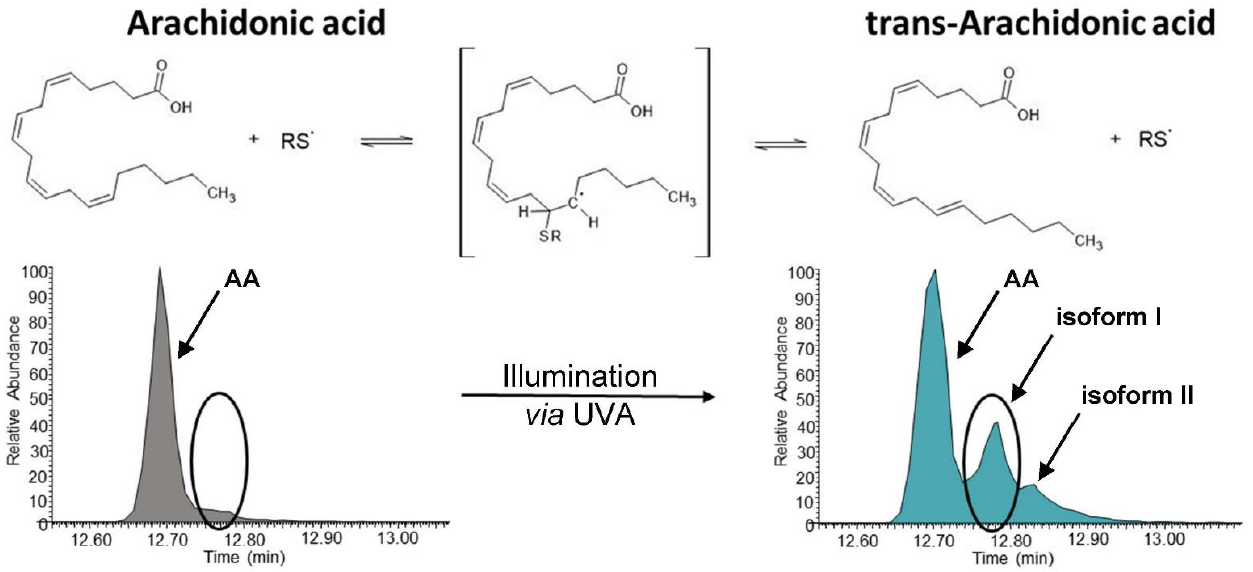
Biomolecules 2022 , 12 , x Figure 3. Formation of trans-arachidonic acid isoforms I and II obtained by UVA illumination of Figure 3. Formation of trans -arachidonic acid isoforms I and II obtained by UVA illumination of arachidonic acid in the presence of a sulfhydryl donor ( β -mercaptoethanol) in a cell-free experiment.